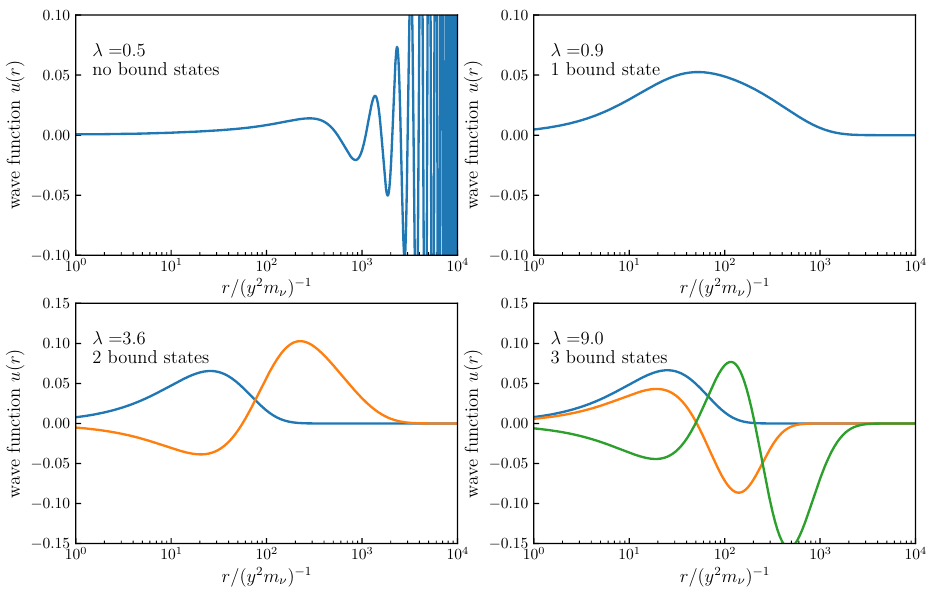
Figure 1 . The radial dependences of the wave functions of neutrino bound states for different values of the interaction strength λ defined in eq. (3.4). In all the panels we take the orbital momentum l = 0 . For λ = 0 . 5 , since no bound states can be formed, we plot the wave function with the lowest